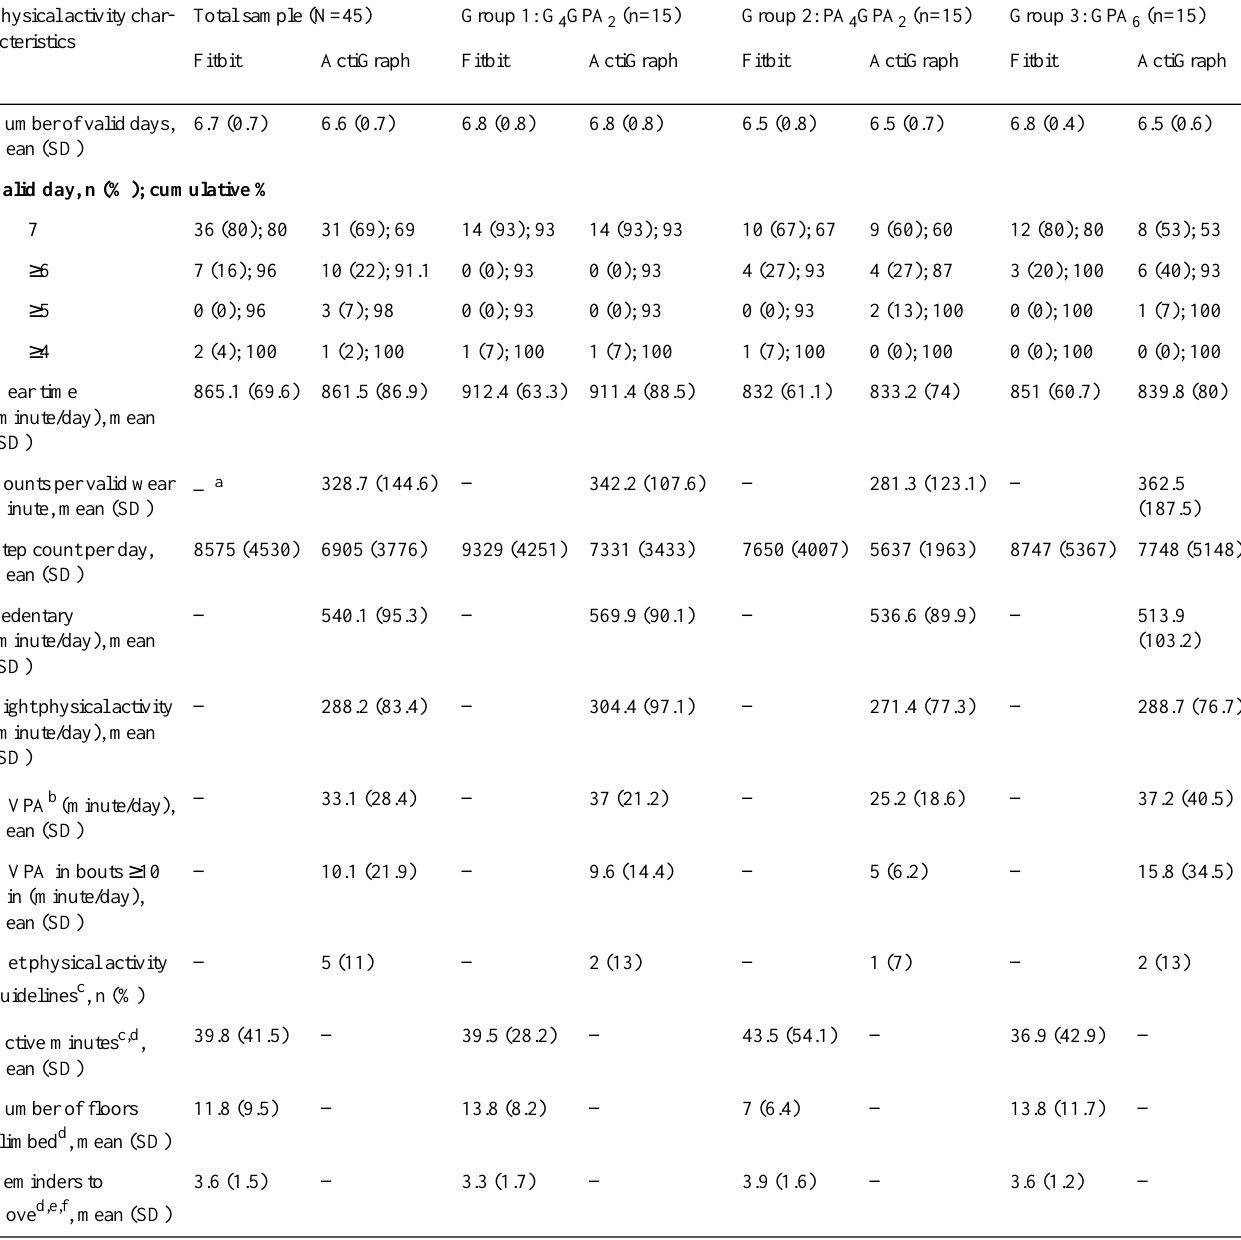
Table 2. Participants’baseline physical activity characteristics stratified by group.